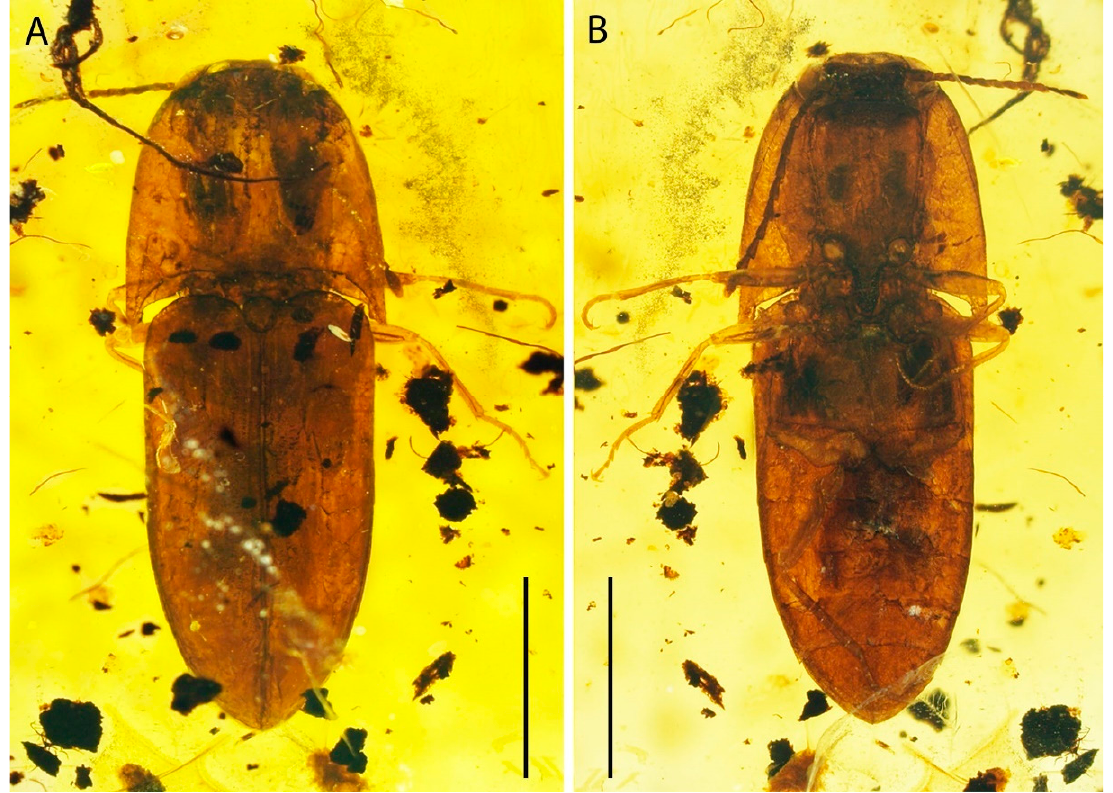
Figure 1. Morphology of Burmogonus cretaceus gen. et sp. nov. ( A ) Habitus, dorsal view; ( B ) habitus, ventral view. Scale bars: 2.0 mm.